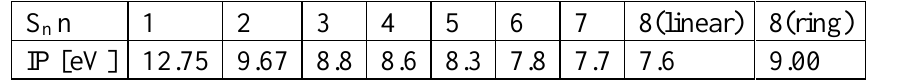
. The numbers are averages over similar n